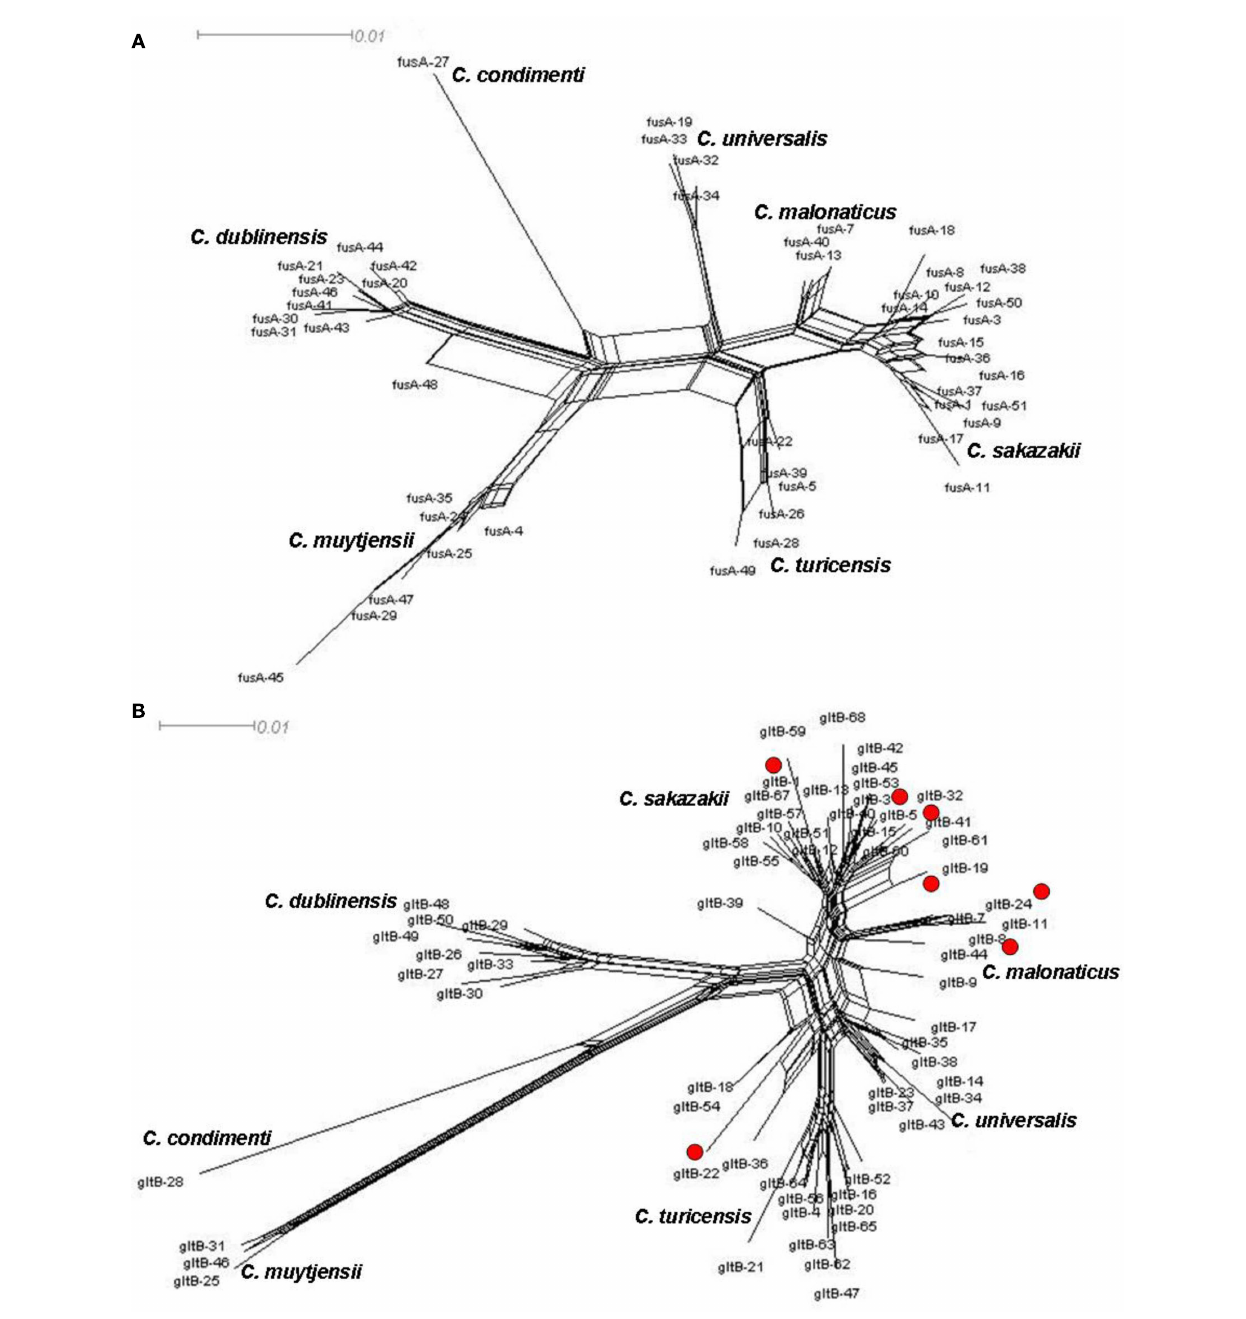
FIGURE 3 | Neighbor-net of allele sequence alignment for (A) fusA and (B) gltB generated for the Cronobacter MLST dataset indicating diversity and recombination events. The figure has been drawn to scale using Splitstree4.The formation of parallelograms indicate possible recombination events.